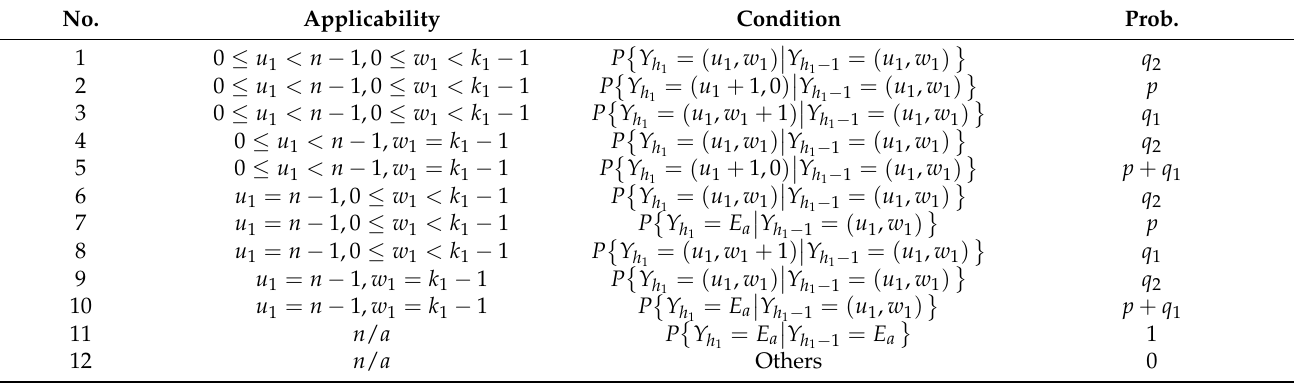
Table 1. Transition probabilities in Λ 1